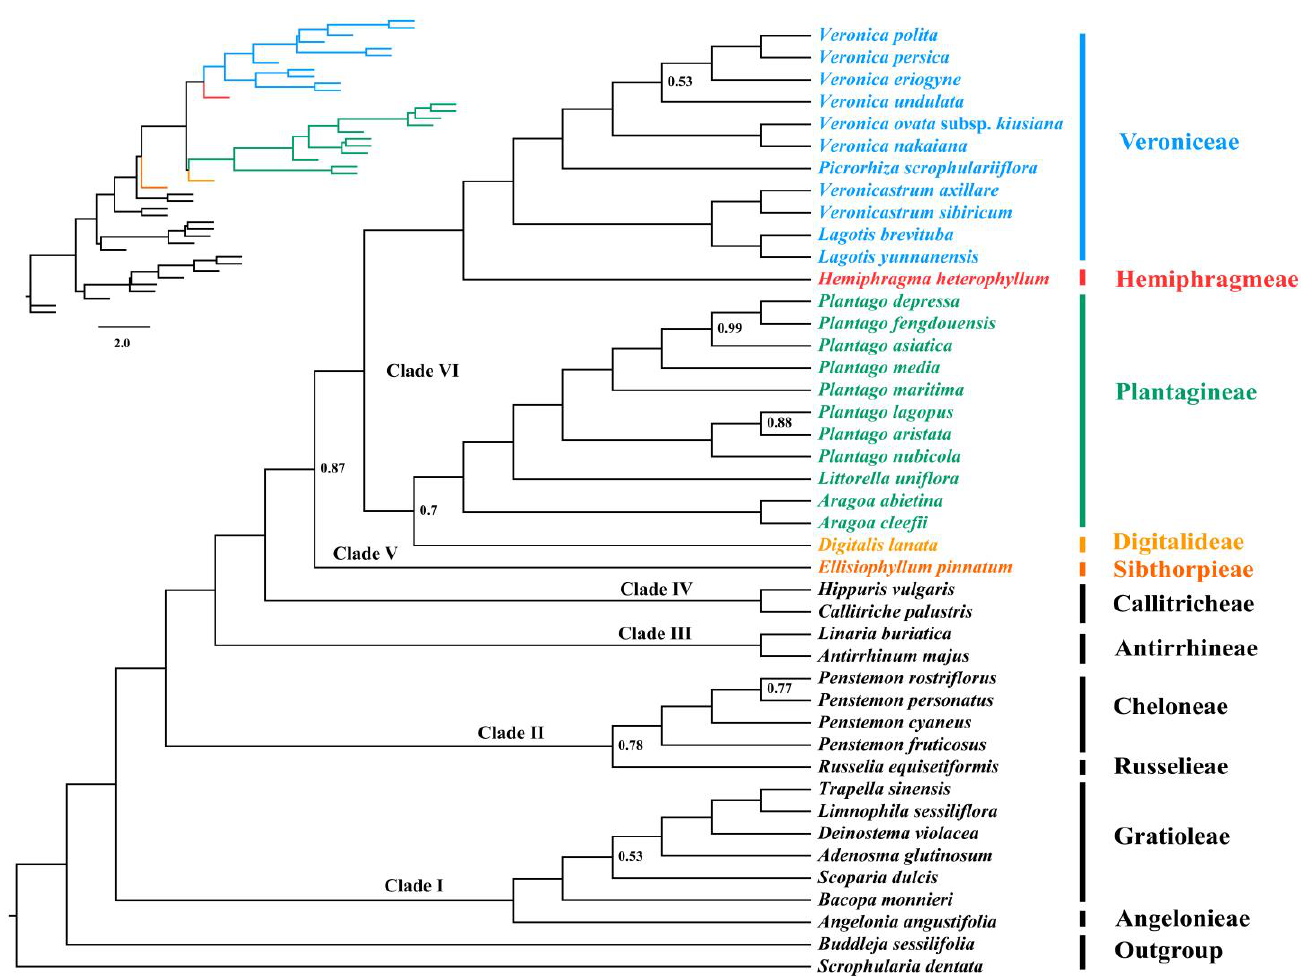
Figure 5. Species tree of Plantaginaceae reconstructed by ASTRAL based on 68 plastid protein-coding genes. Values at nodes represent local posterior probabilities (LPP) and all unlabeled nodes indicate high support values (LPP = 1.00). All 68 plastid gene trees of Plantaginaceae were shown in Figure S2.